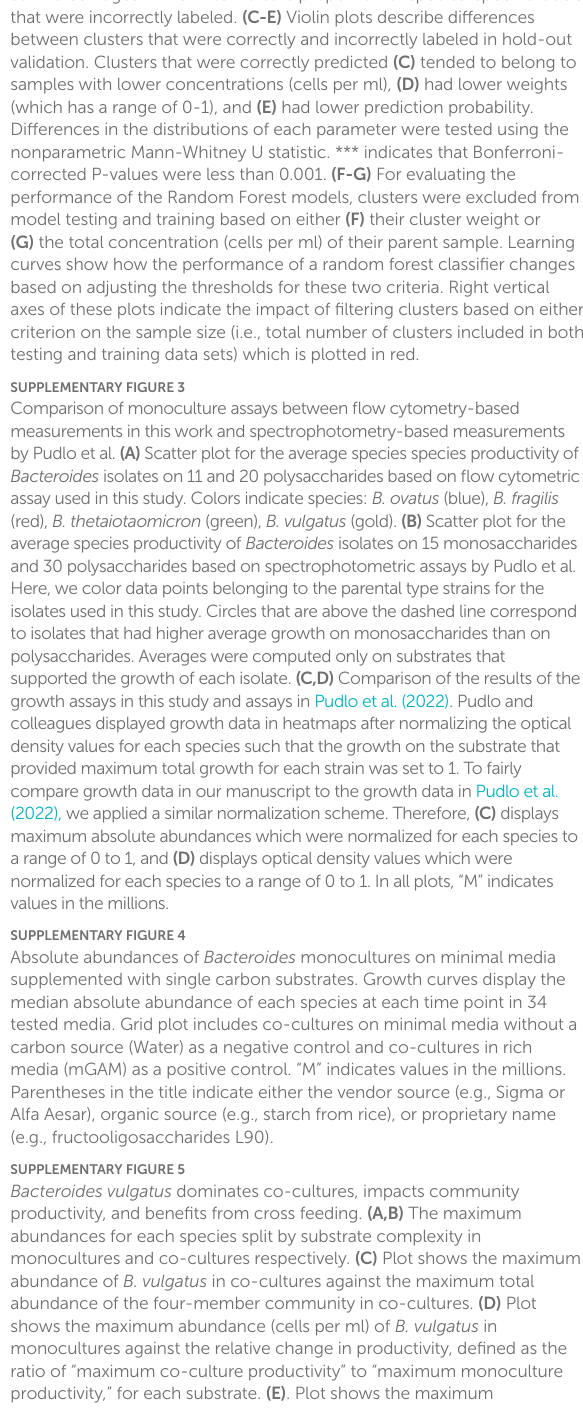
SUPPLEMENTARY FIGURE 2 Random Forest model assigns species identity to flow cytometric clusters with high accuracy. (A) Mean and standard deviation for the importance of features used by the Random Forest classifier as estimated by a permutation test (“permutation_importance” function in the “inspection” module of “scikit-learn” version 0.24.0). (B) Plot shows counts and directions of prediction errors for each species. Arrows indicate direction of errors from the true species label to the incorrect species label.